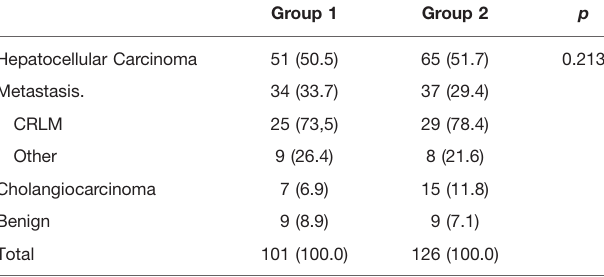
TABLE 2 | Liver pathologies treated pre-COVID (Group 1) and during pandemic (Group 2).